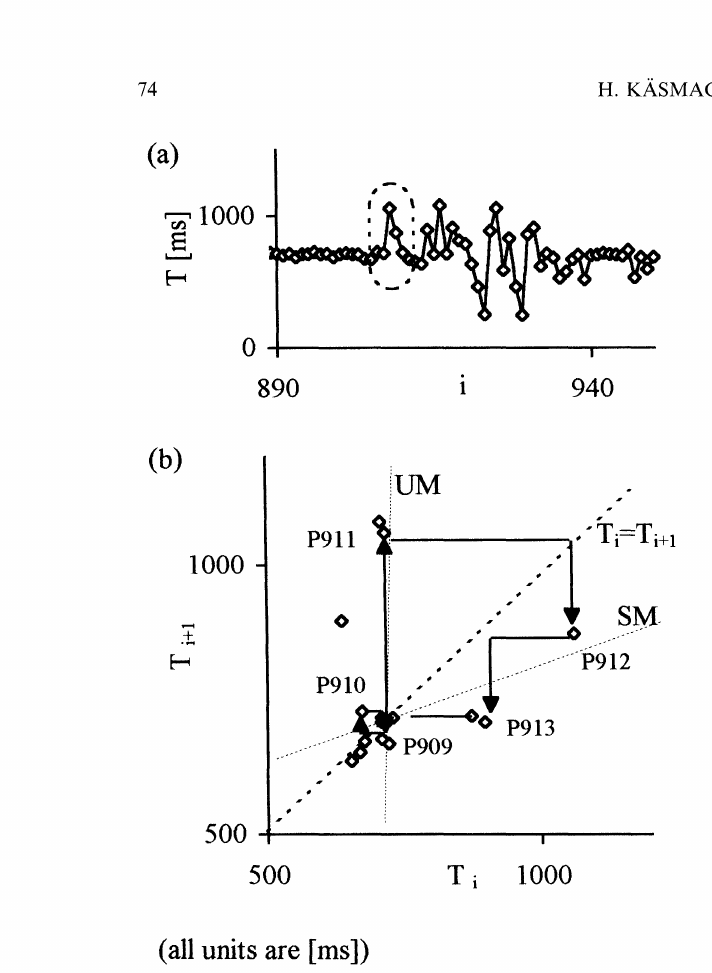
FIGURE 8 Example of a non-linear deterministic registra- tion with evidence of a stable (SM) and unstable manifold (UM): (a) shows the concerned part of the registration. Note that relatively stable regions are interspersed by inter- val lengths which undergo rapid changes. (b) is the specific Poincar-plot of the